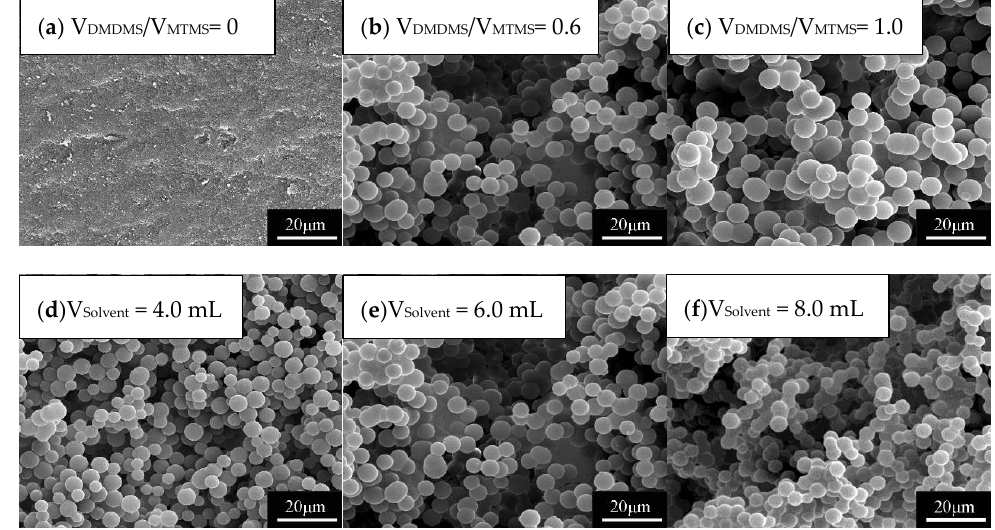
Figure 2. SEM images of flexible MSQ aerogels (without surface modification) prepared with varied volume ratios of co-precursors and solvent volumes (total volume of co-precursors is 2.0